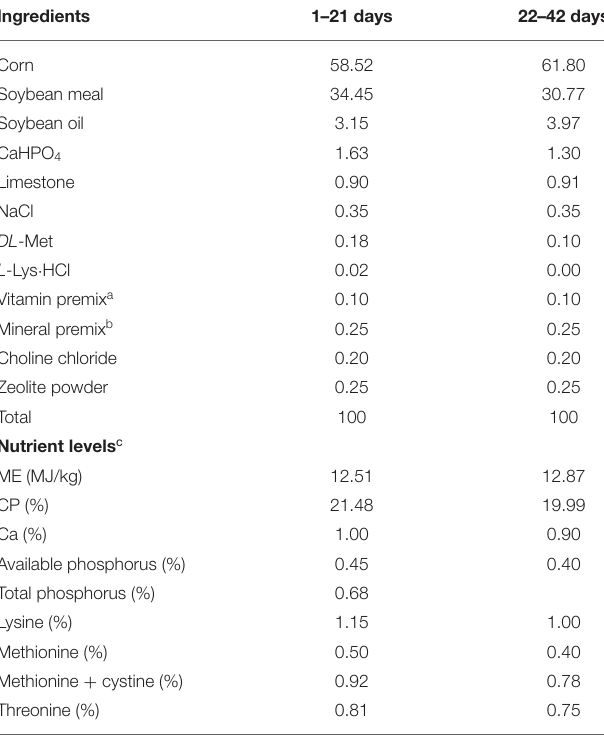
TABLE 1 | Composition and nutrient level of basal diet (as feed